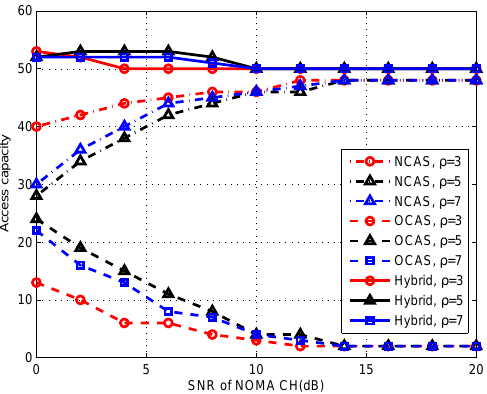
Figure 7. Comparison of the access capacity among the hybrid NOMA-OFDMA, NCAS, and OCAS, ρ = 3, 5, and 7 dB, U = 60.